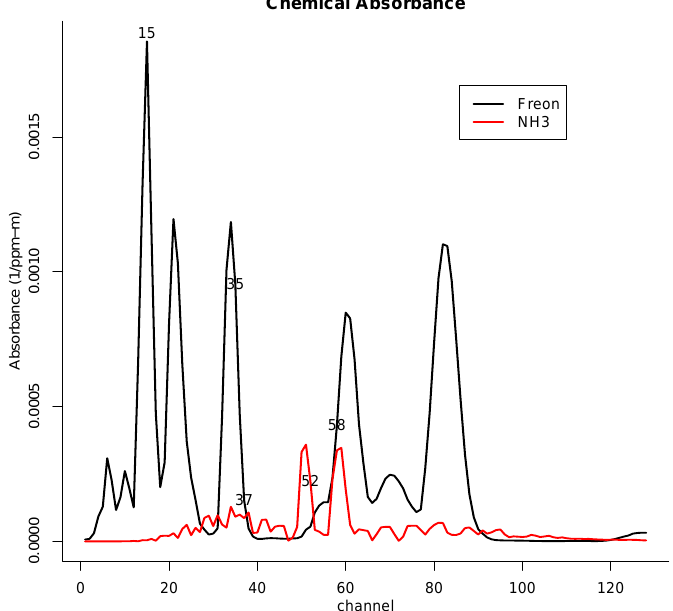
Figure 2. Chemical absorbance spectra for Freon-114 and NH